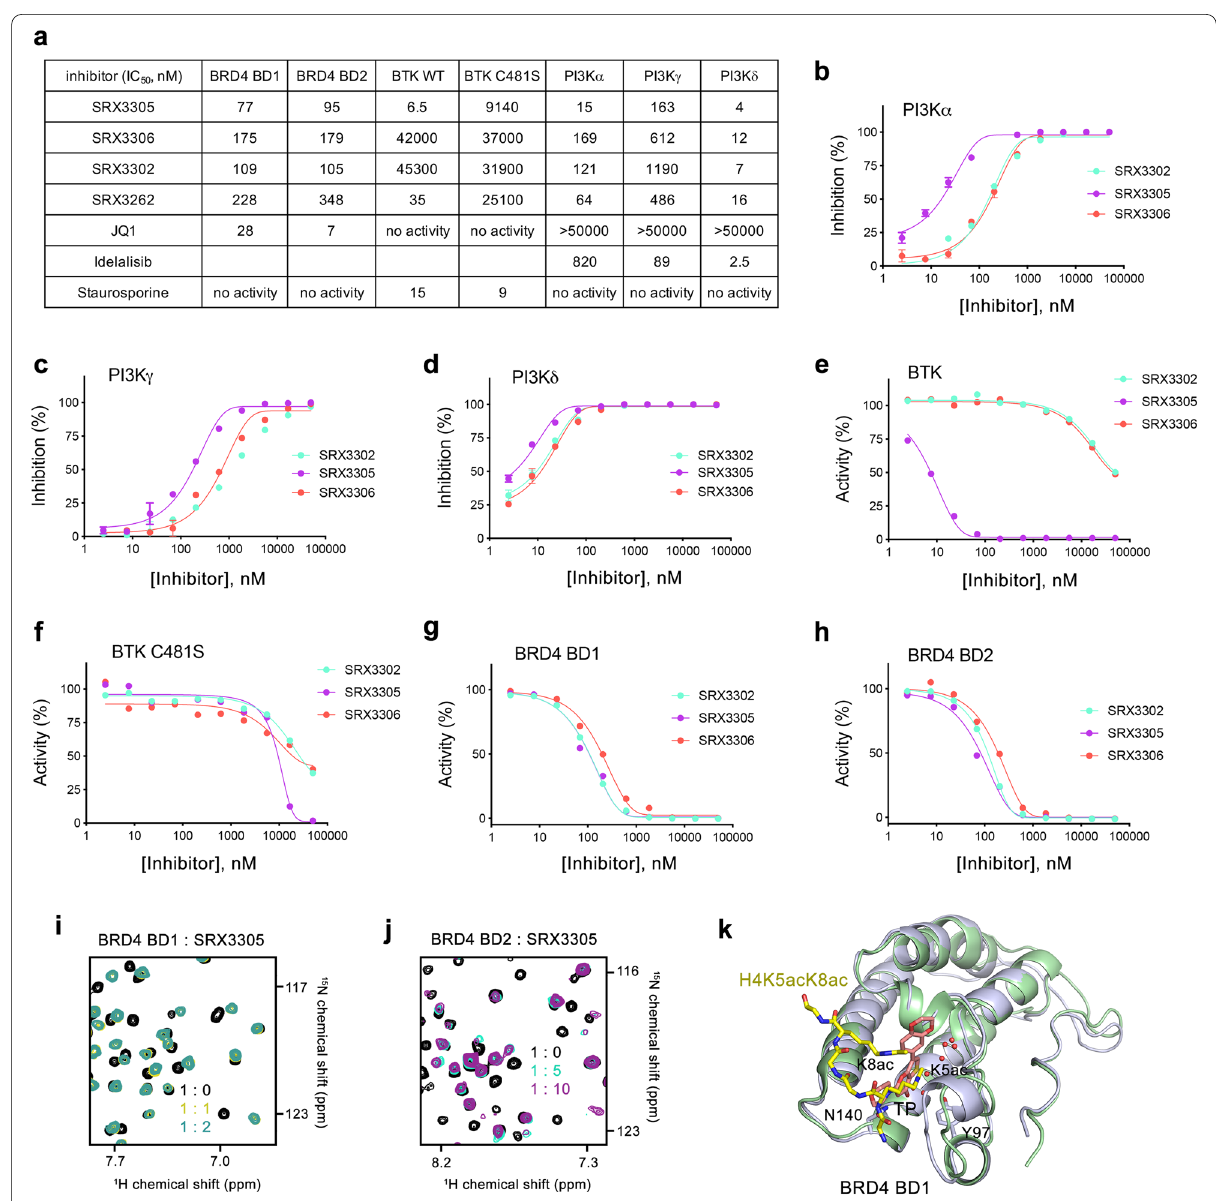
Fig. 1 SRX3305 is a potent triple activity BTK/PI3K/BRD4 inhibitor. a IC 50 values (nM) of SRX3305 and other indicated inhibitors of BRD4, PI3K and BTK as measured by displacement binding and kinase assays. Values for SRX3262 are from [30] and values for Idelalisib are from [32]. b-h IC 50 curves for indicated targets by indicated inhibitors. i, j Superimposed 1 H, 15 N HSQC spectra of uniformly 15 N‑labeled BRD4 BD1 and BRD4 BD2, recorded while SRX3305 was titrated in. The spectra are color‑coded according to the protein: inhibitor molar ratio (inset). k Structural overlay of the complexes: BRD4 BD1 (light blue) with the TP inhibitor SF2523 (pink) (PDB: 5U28) [27] and BRD4 BD1 (light green) with H4K5acK8ac peptide (yellow) (PDB: 3UVW) [33]. Water molecules are shown as red